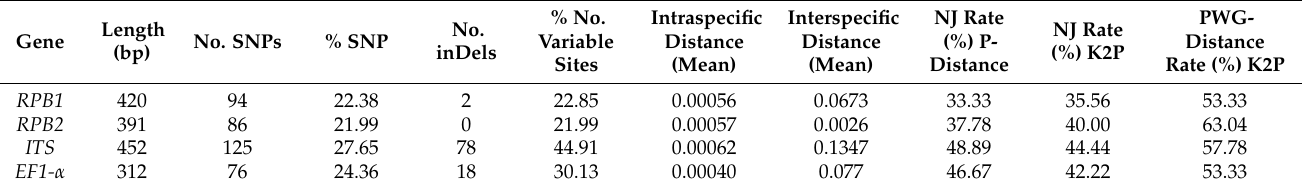
Table 2. The variability characteristics of single DNA molecular barcoding genes in Morchella